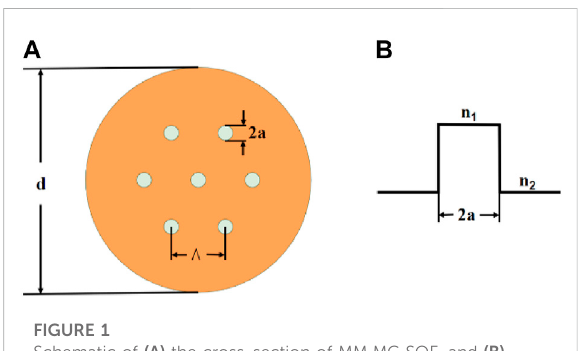
FIGURE 1 Schematic of (A) the cross-section of MM MC SOF, and (B) the index pro fi le of the core